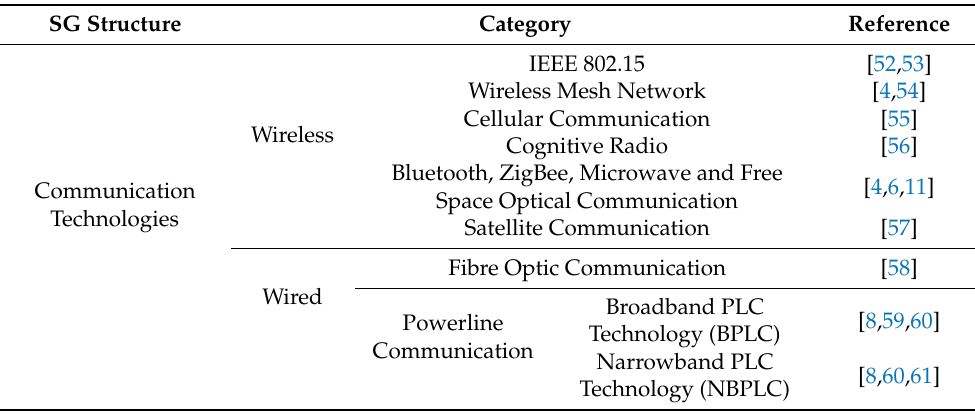
Table 1. Classification of communication technologies in Smart